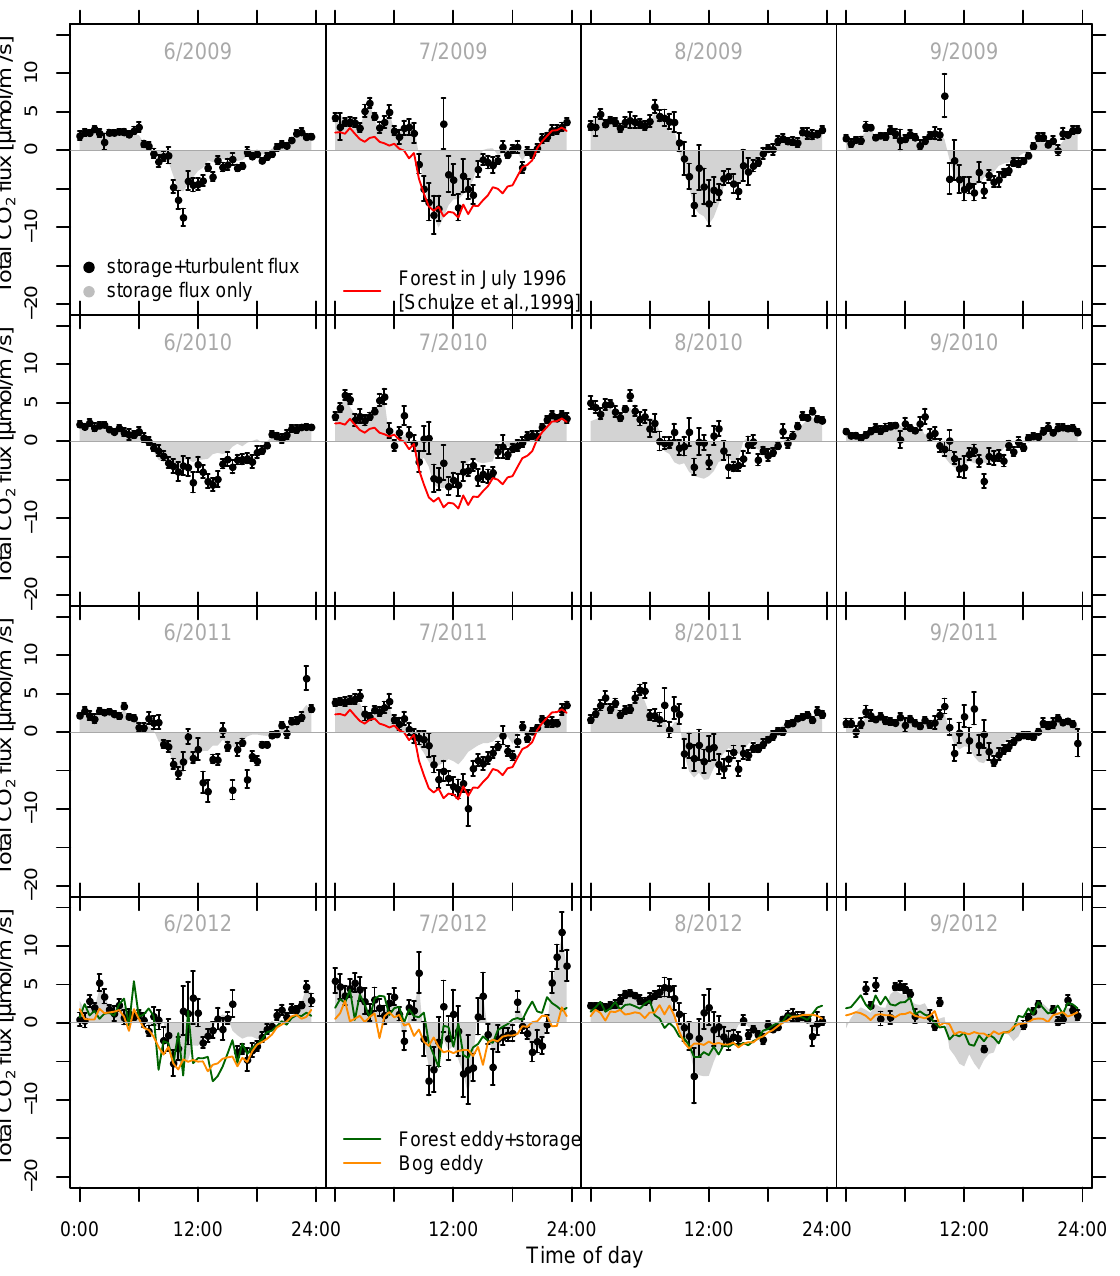
Fig. 7. Diurnal cycle of the total CO 2 flux estimate with standard error of the mean for all summer months: the grey area indicates the storage flux component; (for guidance) red line: eddy covariance data in July 1996 from a 67-year-old stand in Zotino from Schulze et al. (1999); green line: eddy covariance data and storage flux from the new forest site; and orange line: eddy covariance data from the new bog